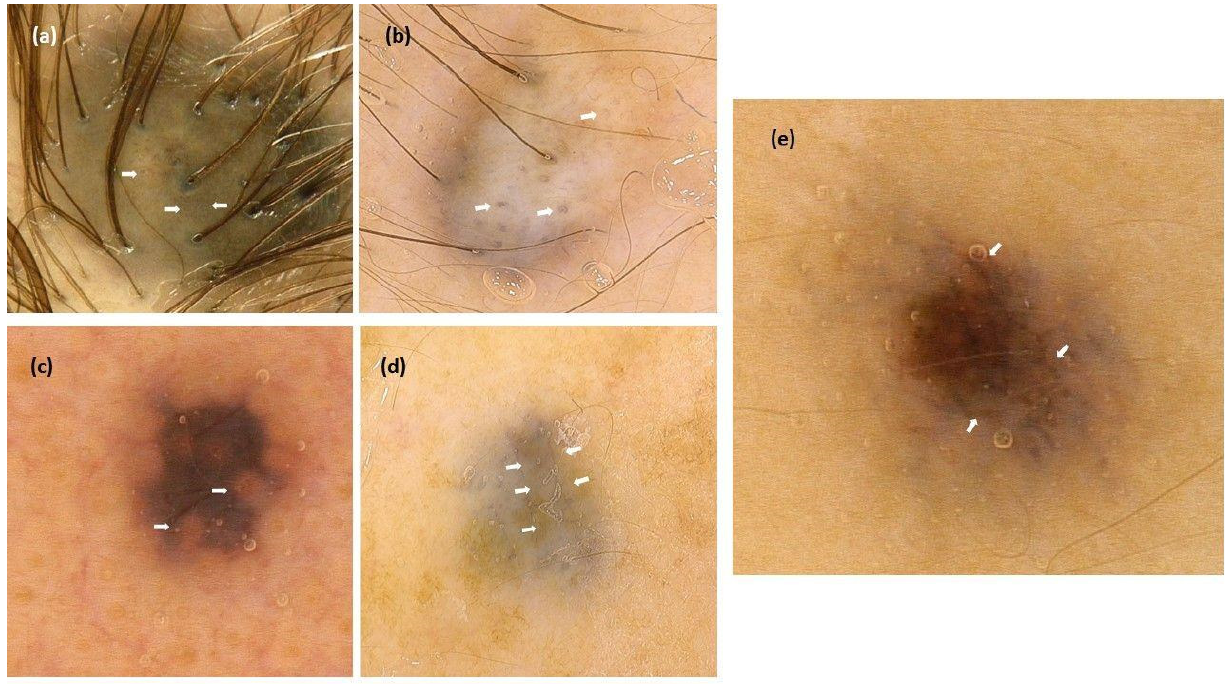
Figure 2. Examples of dermoscopic structures observed in the study, whose prevalence was not previously reported in the context of blue nevi (arrows). ( a ). Skin-colored circles; ( b ). Gray circles; ( c ). Follicular ostia with no pigmentation; ( d ). Blue prominent skin markings over blue-gray background; ( e ).